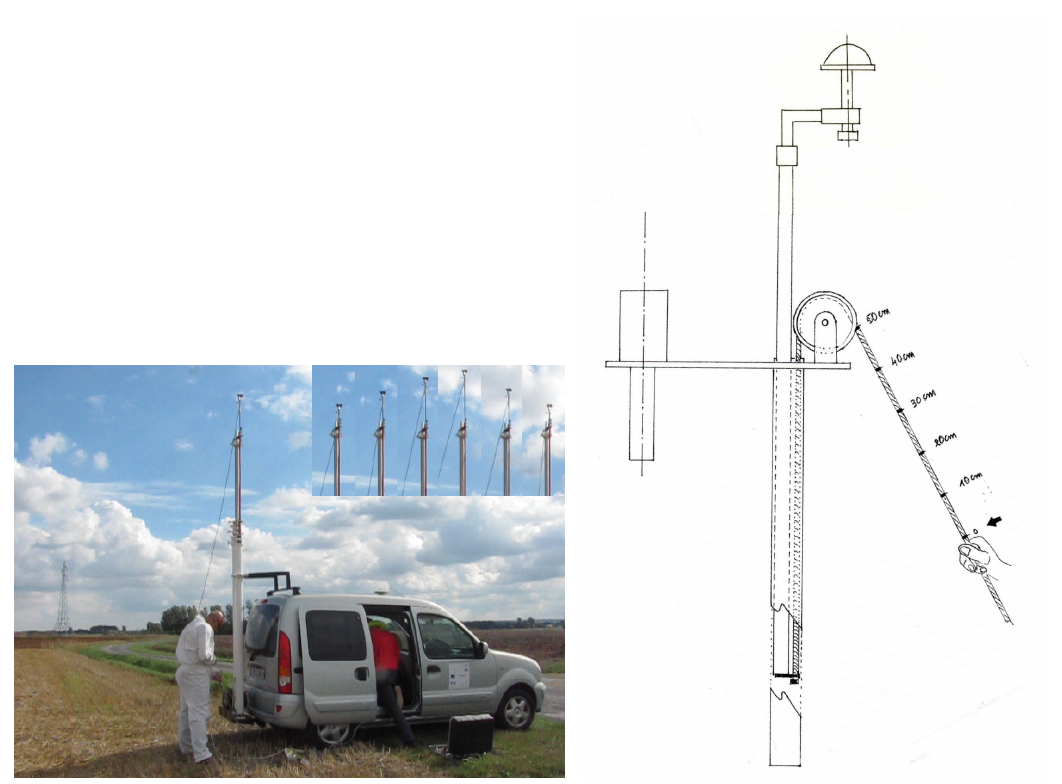
Figure 10. The vehicle and its telescopic